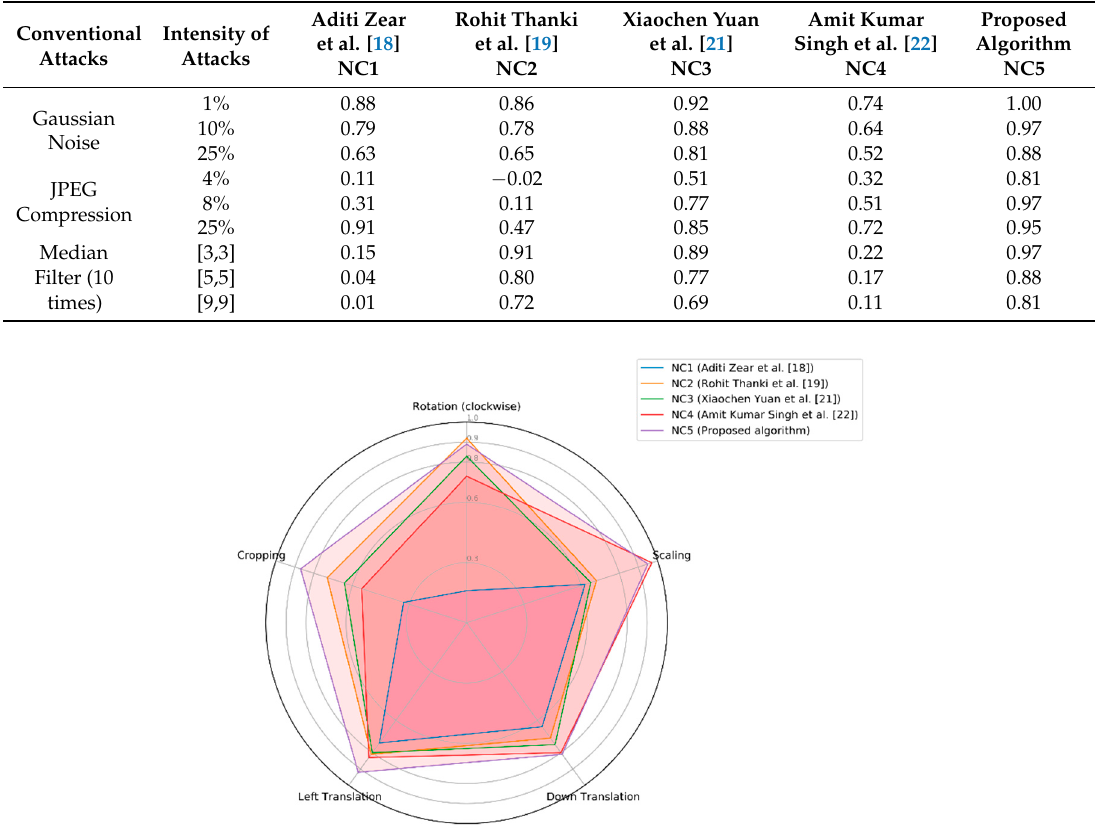
Figure 23. Radar chart of different algorithms under conventional attacks. Table 11. Comparison values of different algorithms under conventional attacks.